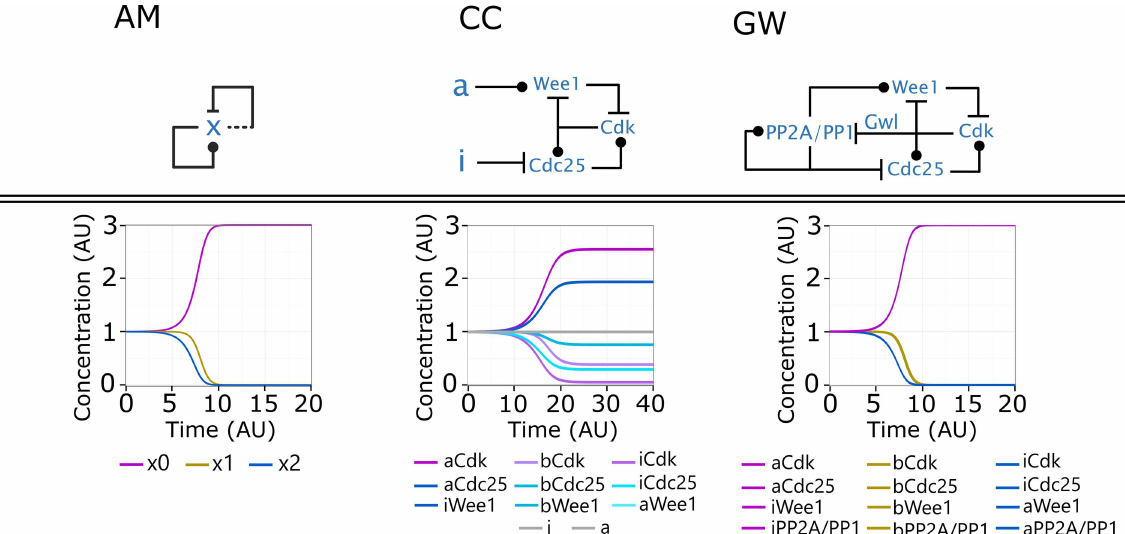
Fig 3. Similarity in switching dynamics between approximate majority (AM) and two cell cycle model systems. Top: AM, representedas an influencenetwork in the notation of Fig 2. CC: The classical cell cycle module of the G2/M transition regulation, representedas a molecularlevel wiring diagram in the notation of Fig 2, with a and i servingas proxiesfor a constant phosphatase counteracting the effects of Cdk. GW: The cell cycle model extendedwith the regulationof phosphatases (PP1 and PP2A) through the Greatwall kinase pathway[45,46],represented as molecularwiring diagram.Bottom: Examples of the deterministic behaviour of each network initiated from an undecided state in which all species are present in similar amounts. The AM and the GW systems show equal dynamics. Only the variousforms of Cdk of the CC system resemblethe behaviourof AM and GW, but becauseof the external influence of a and i, the other species do not overlap with these whilethey properlyalign with them in GW.